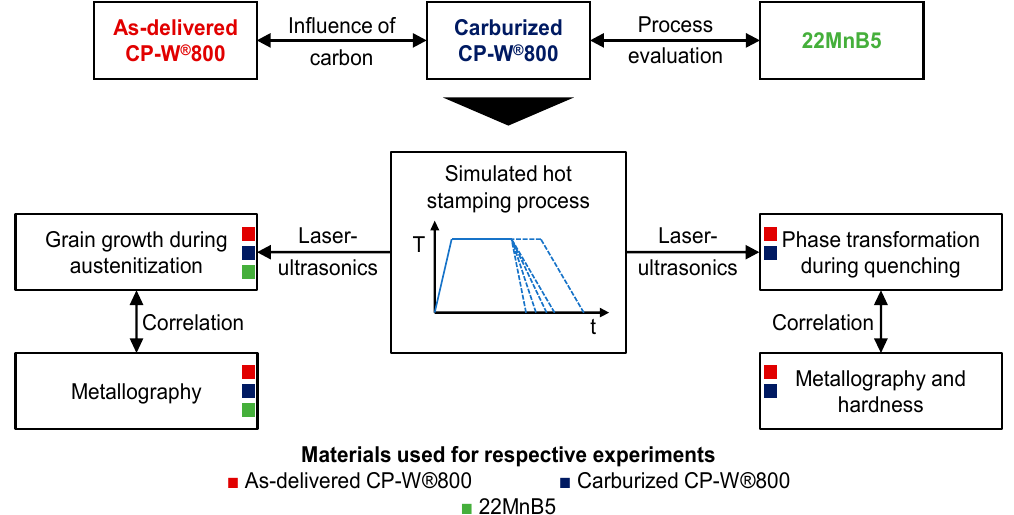
Figure 1. Methodology used to investigate the microstructural evolution during hot stamping of a carburized complex phase steel.